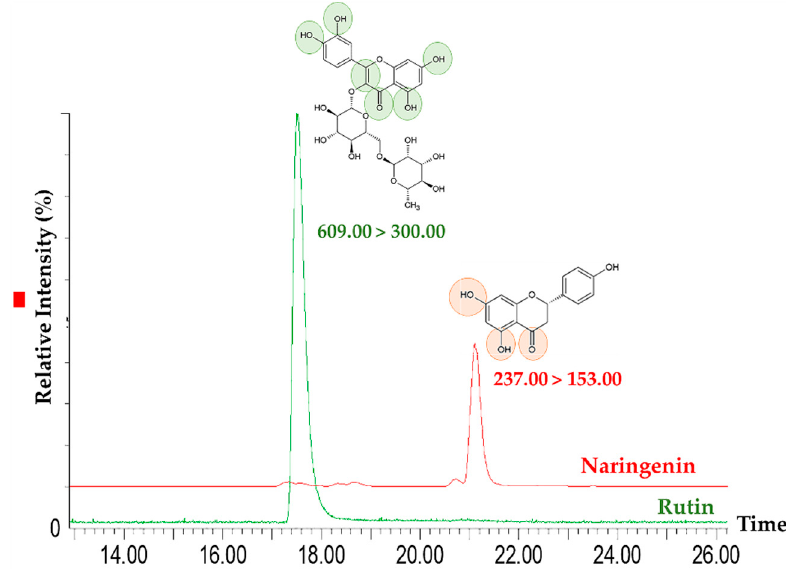
Figure 2. MRM chromatograms of rutin and naringenin in elderflowers’ methanolic extract.